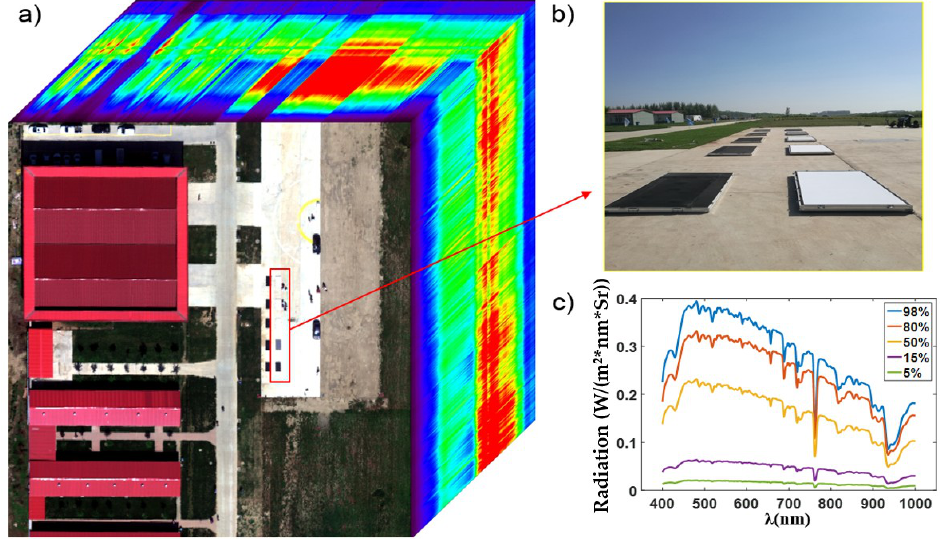
Figure 18. Hyperspectral image of diffuse reflectance targets (( b ) is the picture of diffuse reflectance targets, and ( c ) shows the radiation curves of these diffuse reflectance targets).